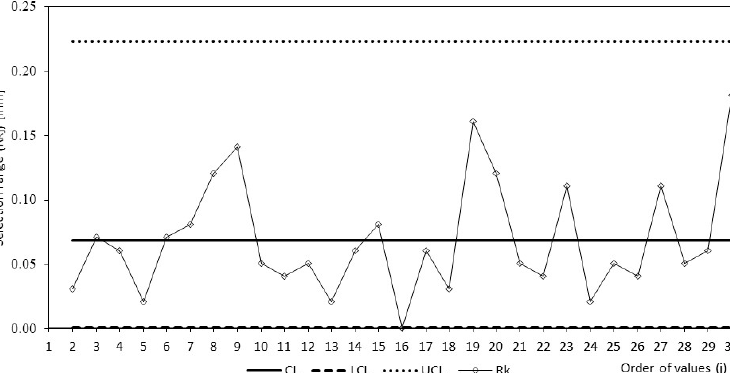
Figure 18. Shewhart control chart for sliding margins for the length parameter, second day.